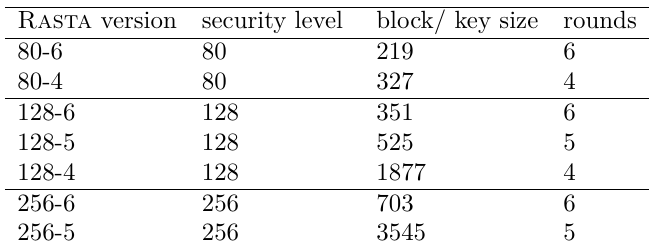
Table 1: Rasta versions.